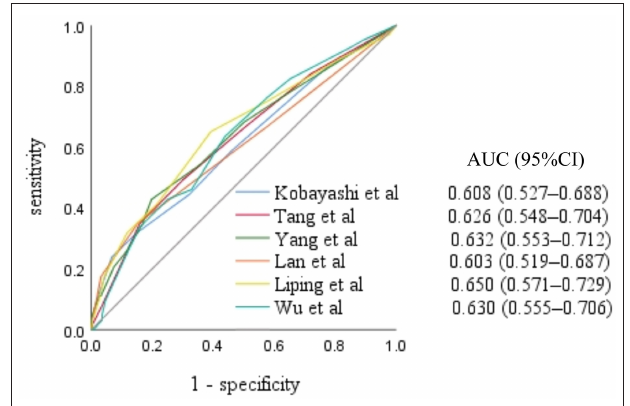
FIGURE 1 | Receiver operating characteristic curves for the scoring systems scores in the intravenous immunoglobulin non-responsive Kawasaki disease group. AUC, area under the curve; CI, confidence